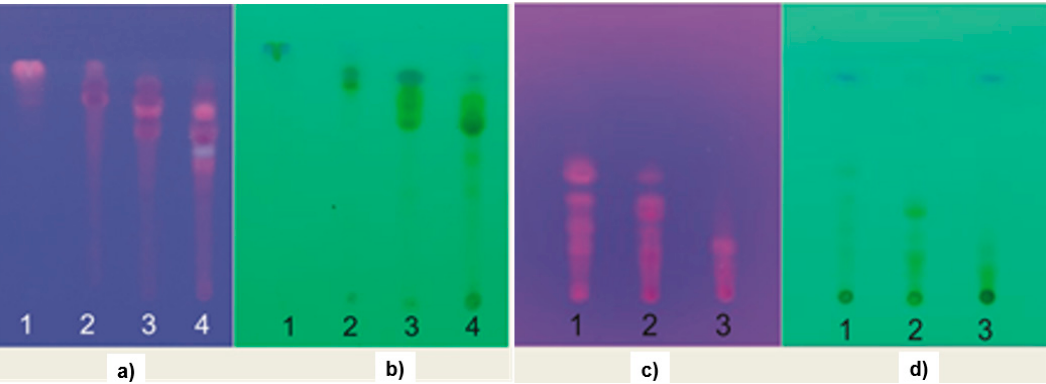
Figure 7. The TLC chromatogram of the fraction 1–4 of Ageratum which are detected under ( a ) UV 365 and ( b ) UV 254 . The fraction 1–3 of Ixora are indicated under ( c ) UV 365 and ( d ) UV 254 .